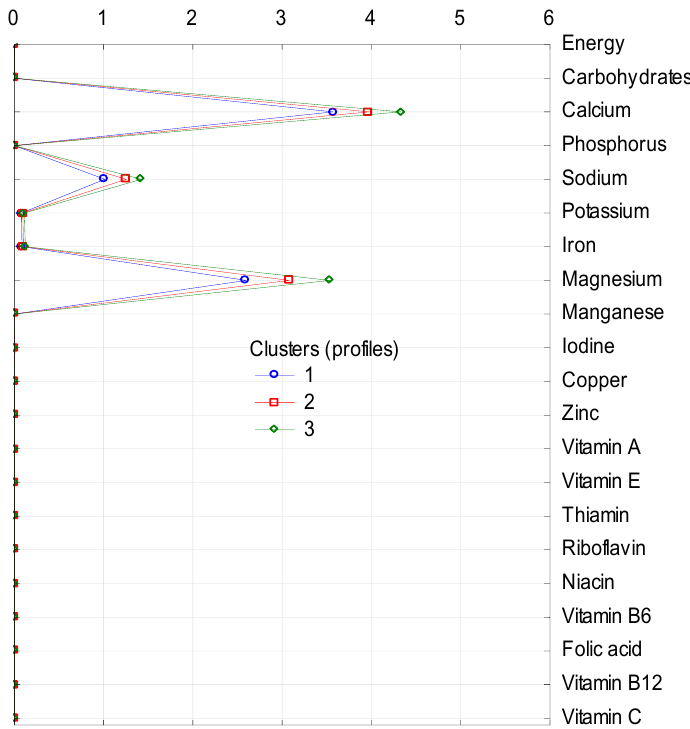
Figure 3. Cluster analysis: supply of energy and analyzed nutrients (in %) from the subgroup of other nonalcoholic beverages to diets in individual clusters. 1,2,3 — number of clusters; characteristics of clusters are presented in Table 3.